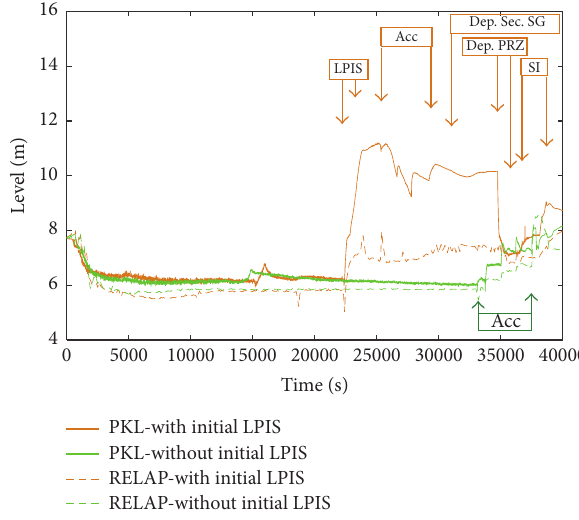
Figure 7: Vessel level. PKL versus RELAP5. Injections and depres- surization (Phase